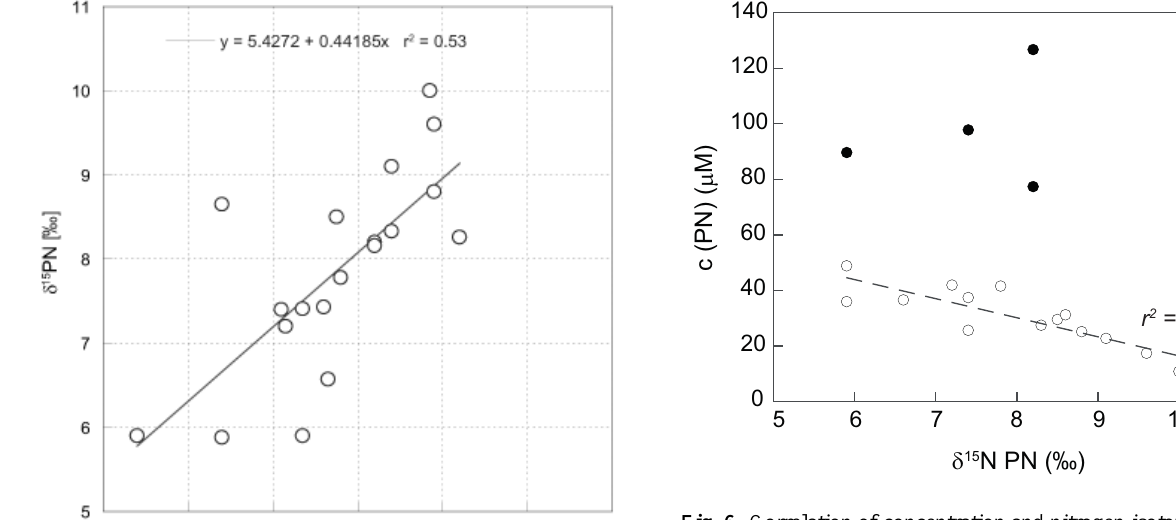
Fig. 6. Correlation of concentration and nitrogen isotope values of particulate matter in the Elbe River. Filled circles are not included in the regression, see text, Sect. 4.2, for and δ 15 PN in the 4